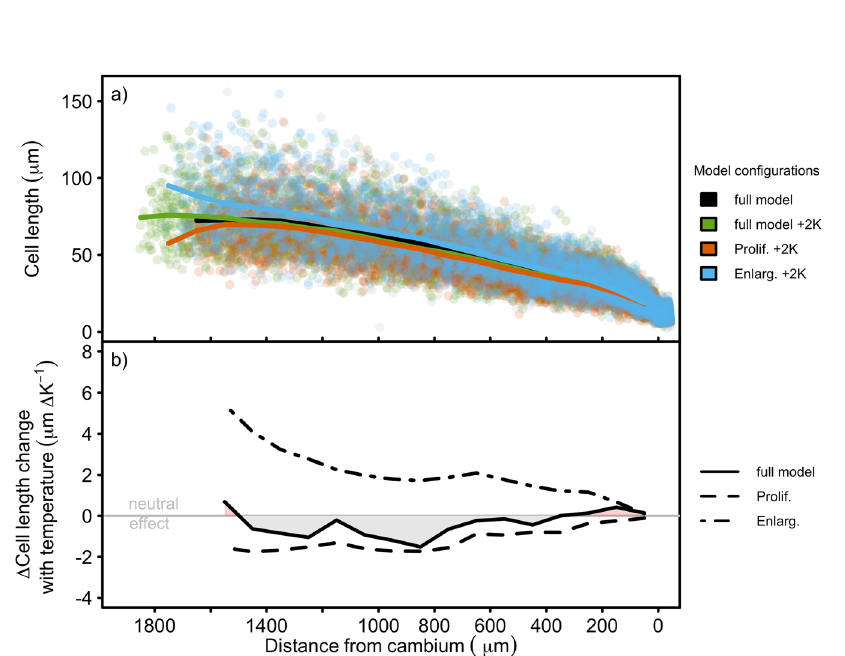
Fig. 4 | Effect of temperature on simulated cell radial length across the fi nal ring under different model forcings in Pinus sylvestris L. growing at the same siteasinFig.2,1995.a Simulatedcellradiallengthsatobserved("fullmodel'')and observed+2K("fullmodel+2K'')temperatureswiththefullmodel.Alsoshownare results with the temperature increment of +2K applied to only proliferating cells ("Prolif. +2K''), or only enlargement-zone cells ("Enlarg. +2K''). Each point is an individual cell at the end of the year and solid lines are mean cell-length pro fi les using a running mean over three adjacent 100 μ m-wide bins. 100 radial fi les were